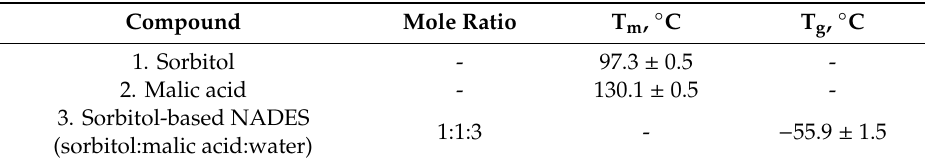
Table 1. The experimental values of the melting point (T m ) for sorbitol, malic acid, and the glass transition temperature (T g ) for sorbitol-based